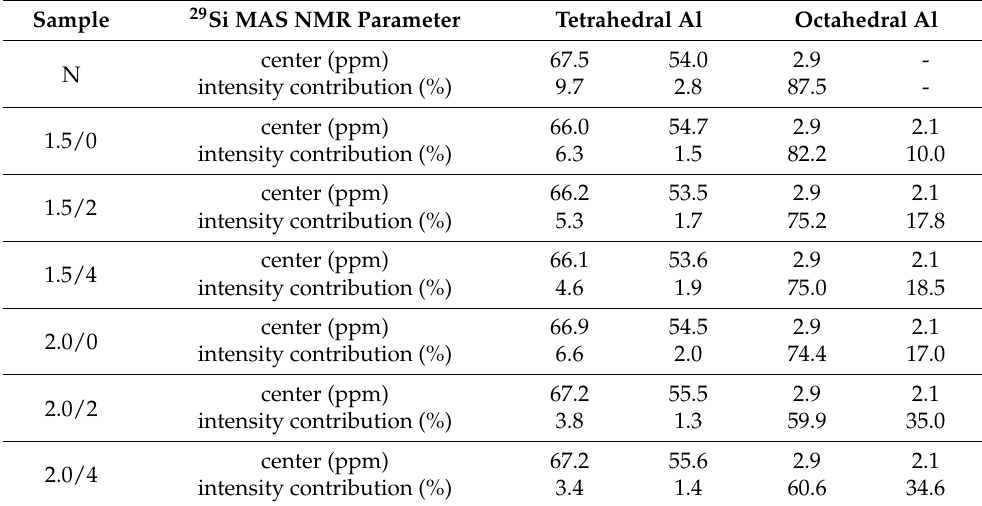
Table 2. Parameters of 27 Al MAS NMR spectra components obtained from